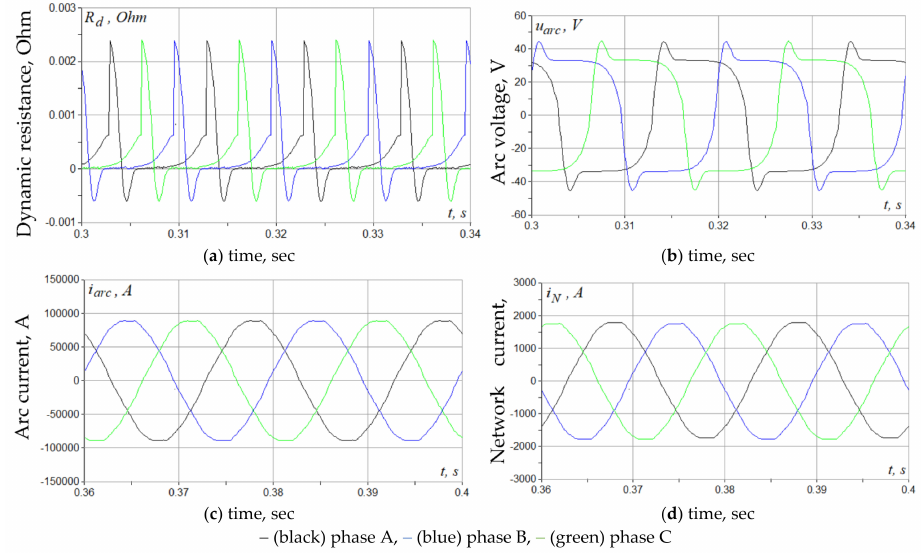
Figure 11. Dynamic arc resistance ( a ), instantaneous values of arc voltages ( b ), instantaneous values of arc currents ( c ), instantaneous values of mains currents ( d ) in steady state for arc length 2